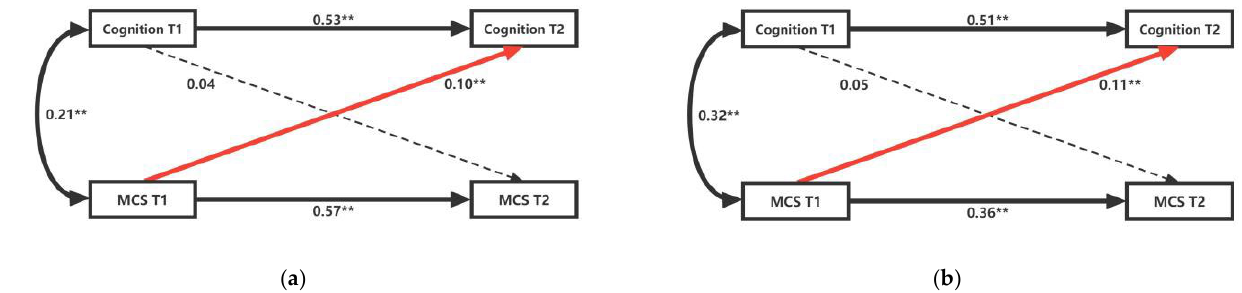
Figure 4. Cross-lag Model of Cognitive Function and HRQoL (no digital usage behavior). ( a ) Model 3: the cross-lag relationship between cognitive function and PCS scores; ( b ) Model 4: the cross-lag relationship between cognitive function and MCS scores. PCS, physical component summary; MCS, mental component summary. ** denotes a statistically significant path coefficient p < 0.001.